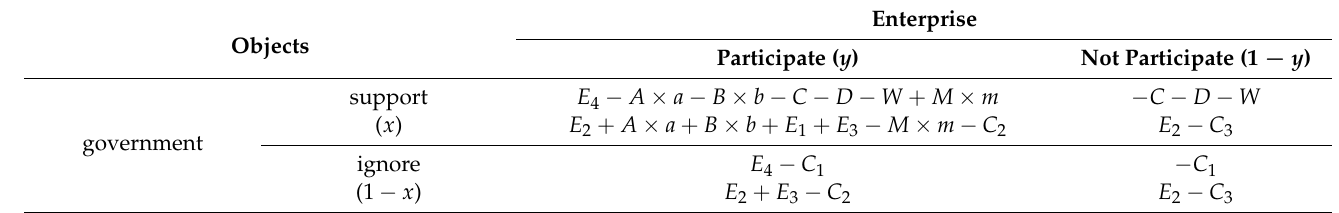
Table 5. Payoff matrix of the evolutionary game between the government and